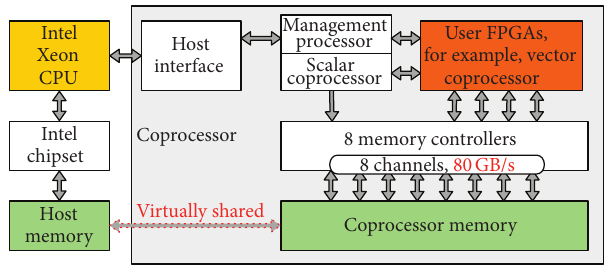
Figure 4: Illustration of the Convey HC-1